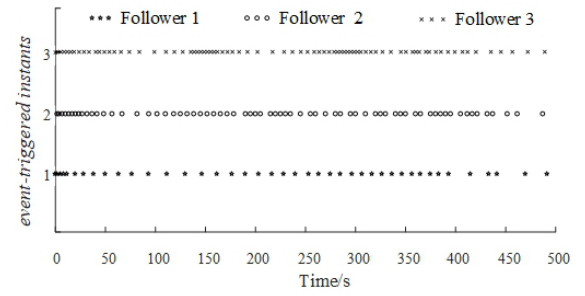
Fig. 5. Moments of